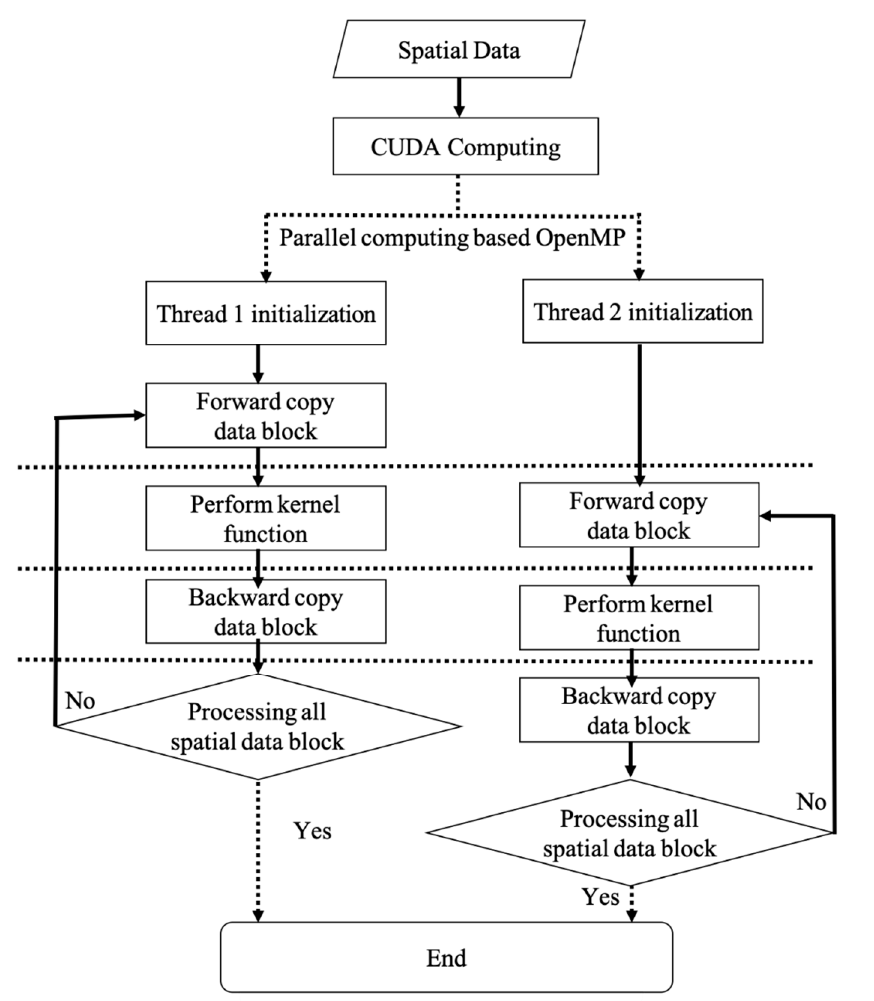
Figure 11. The workflow of the combinational parallel computing framework with GPU and OpenMP.